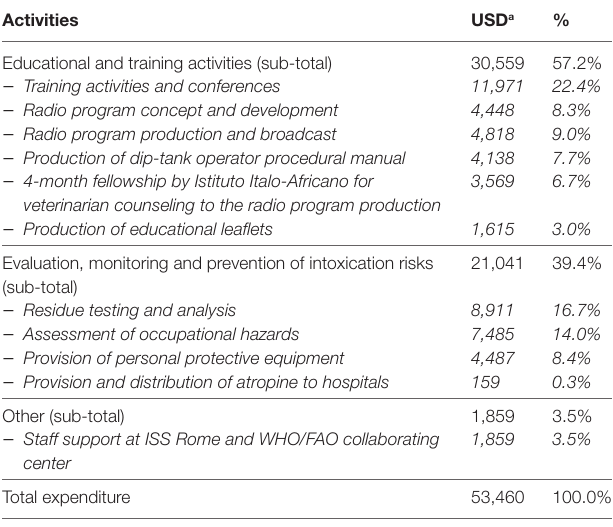
TaBle 2 | Breakdown of the expenditure supported by financing organizations for the implementation of the satellite project by type of